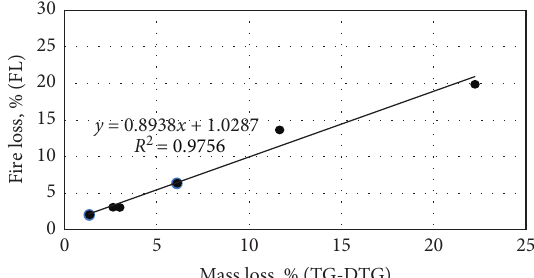
Figure 5: Fire loss (FL) versus mass loss (TG).